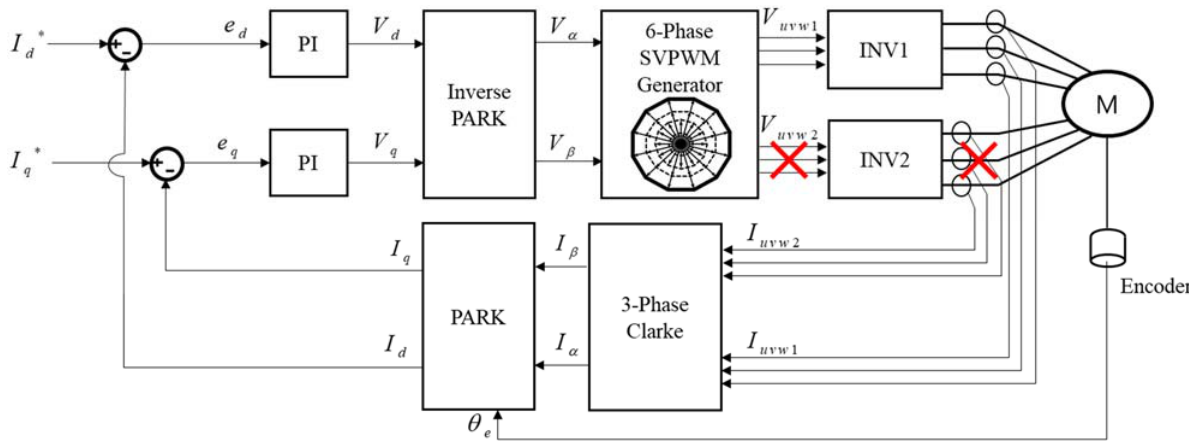
Figure 16. Block diagram for switching control from six- to three-phase operation. Table 11. Transient state of constant-current mode.